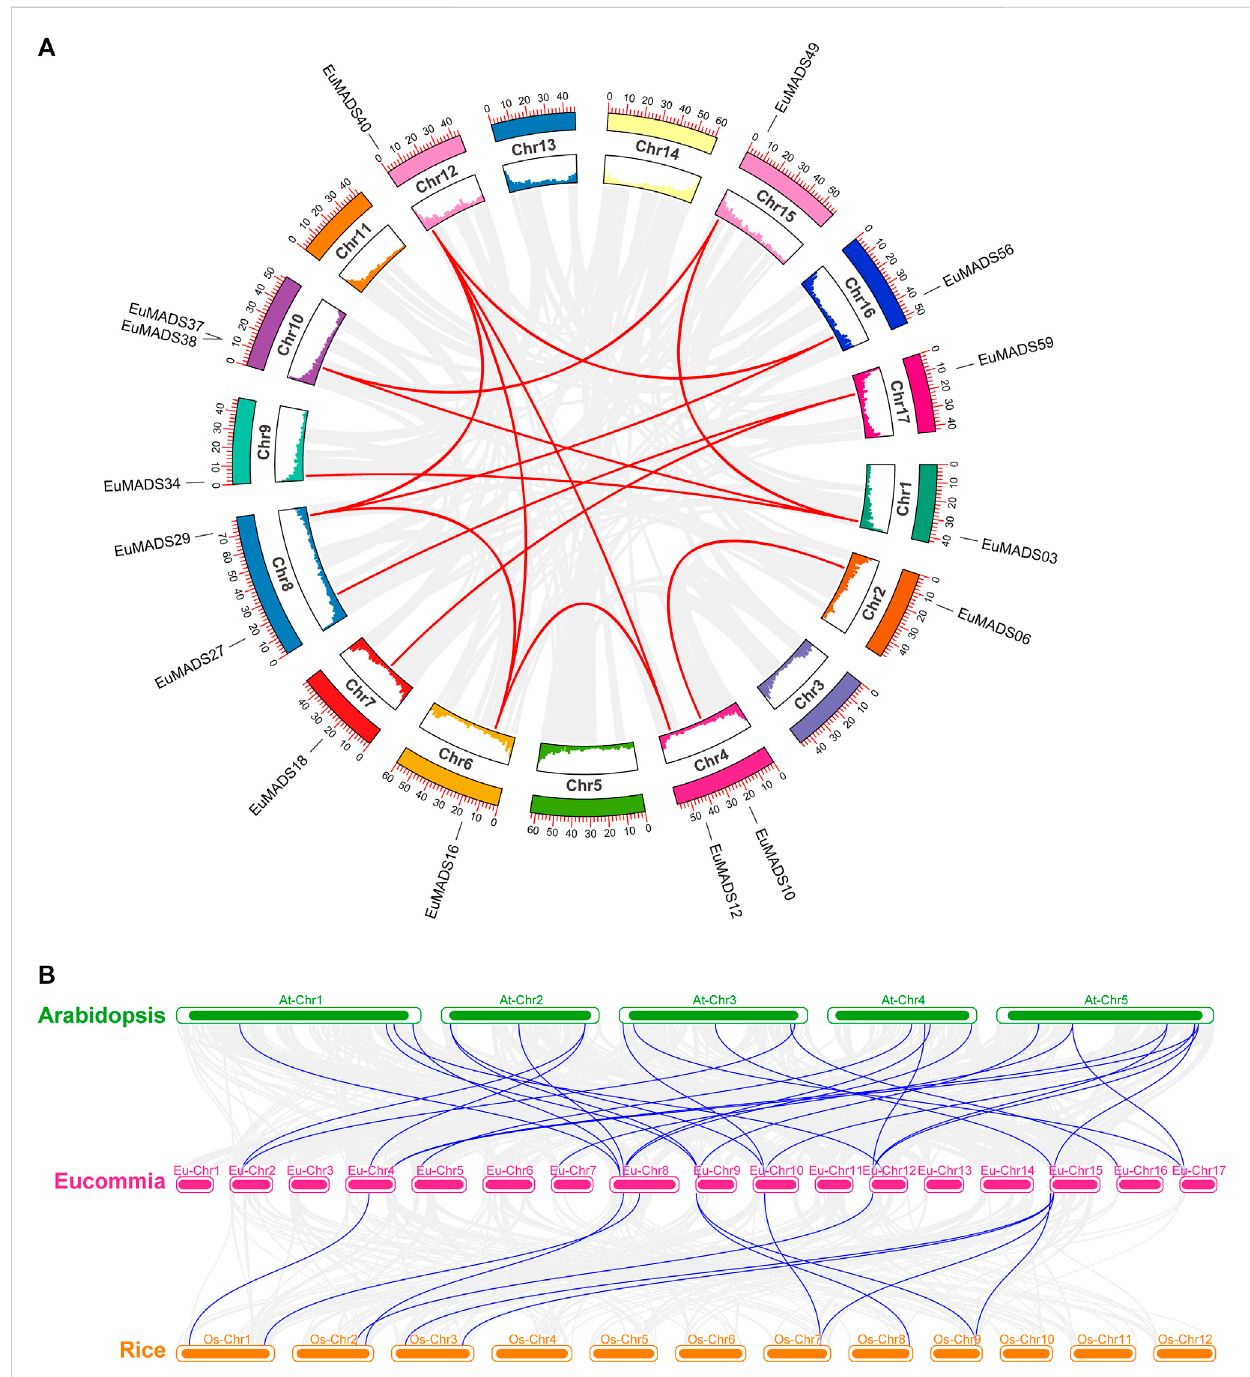
FIGURE 2 Synteny analysis of EuMADS genes within E. ulmoides and between species. (A) Inter-chromosomal relationships of EuMADS genes within E. ulmoides . Gray lines indicate all synteny blocks in E. ulmoides genome, red lines indicate duplicated EuMADS gene pairs. Inside boxes indicate gene density of each corresponding chromosome. (B) Collinear relationships of EuMADS genes between E. ulmoides and the other two species ( Arabidopsis and rice). Gray lines indicate the syntenic blocks between Eucommia and Arabidopsis /rice, blue lines highlight the collinear EuMADS gene